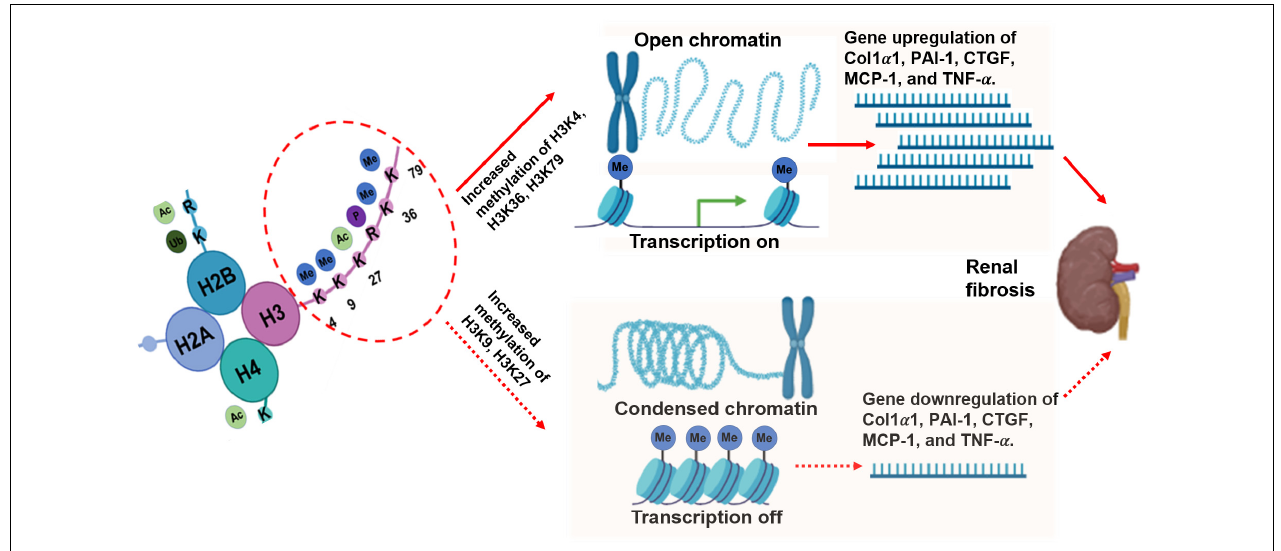
FIGURE 2 | Histone lysine methylation in